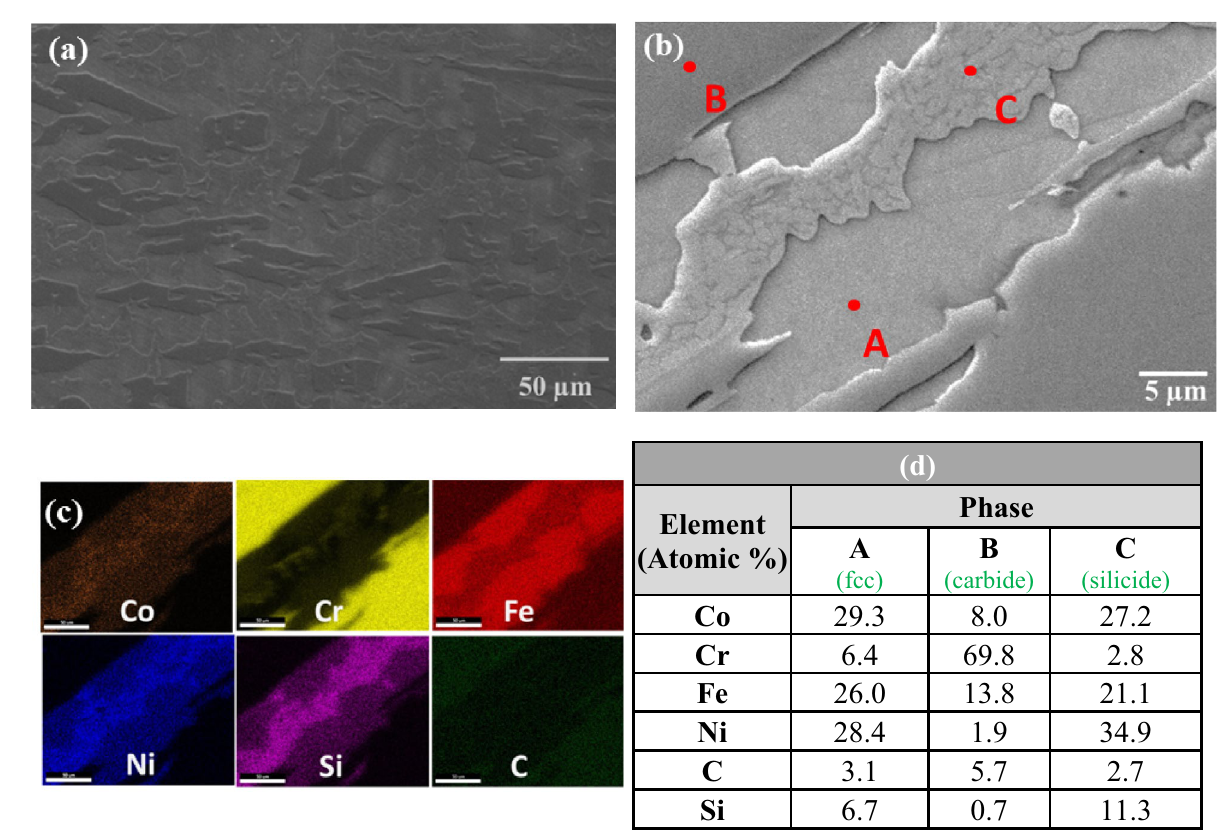
Figure 4. ( a ) SEM image of sample S-3, ( b ) magnified view, ( c ) elemental mapping, and ( d ) EDS results at the indicated